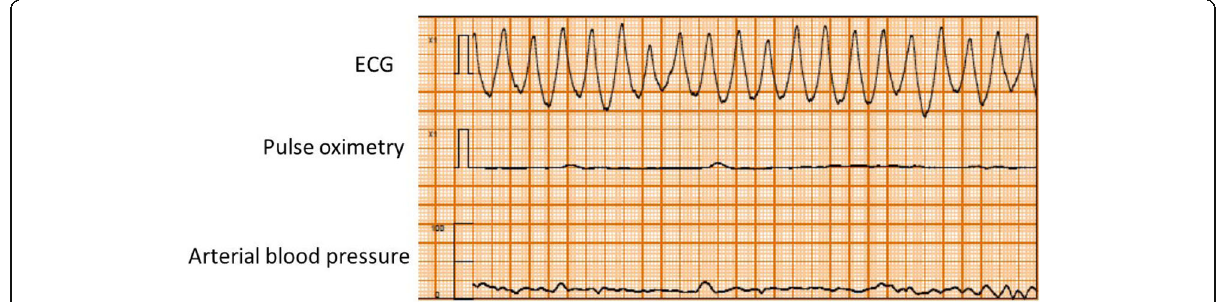
Fig. 4 The ECG monitor again showed ST segment elevation followed by sustained ventricular tachycardia. And ABP was